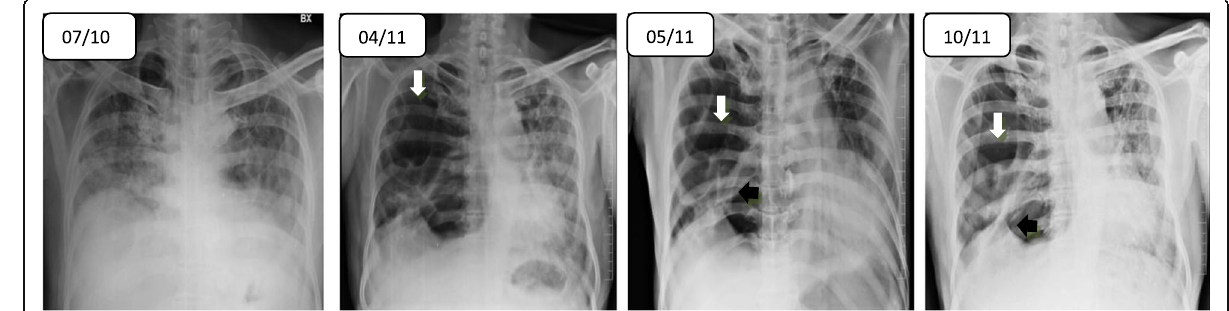
Fig. 3 a – d Consecutive chest x-ray PA view shows progressive increase in lucencies in the right hemithorax (white arrow) with fibrotic changes (black arrow) and mediastinal shift towards the